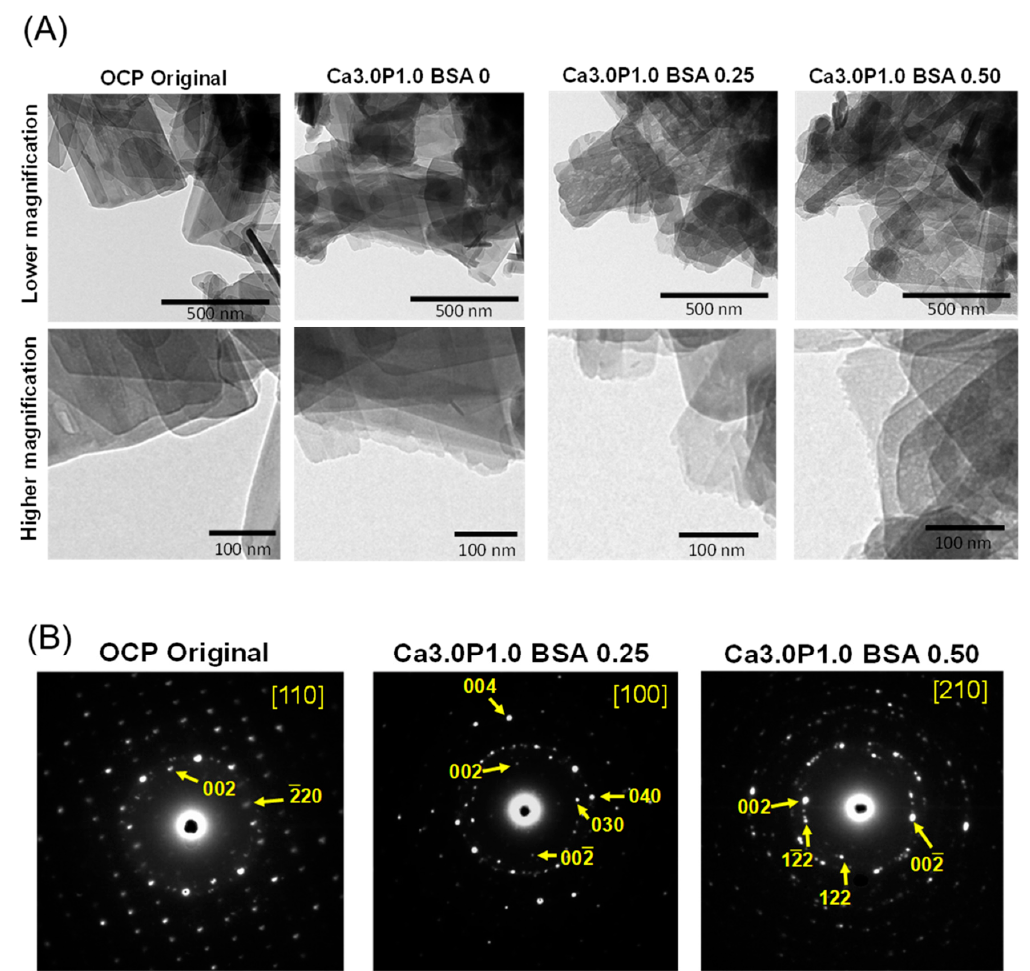
Figure 7. Bright field image of OCP before and after incubation with 0, 0.25 and 0.50 mg·mL − 1 BSA in this Ca3.0P1.0 solution ( A ). Selected area of OCP electron diffraction before and after incubation in 0.25 or 0.50 mg·mL − 1 BSA in the Ca3.0P1.0 solution ( B ).